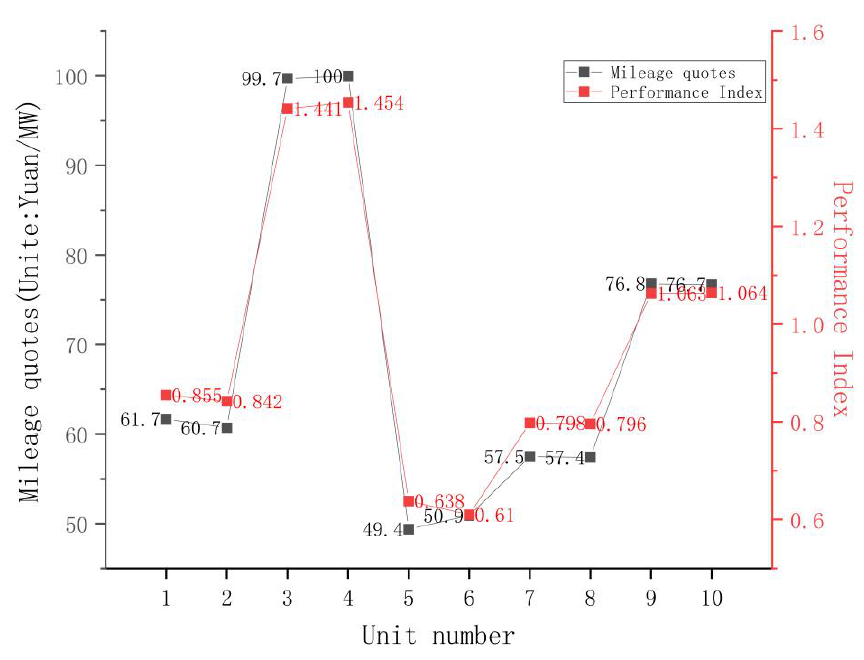
Figure 5. Sichuan uses the PAB pricing mechanism to compare unit price and performance index under scenario 5.